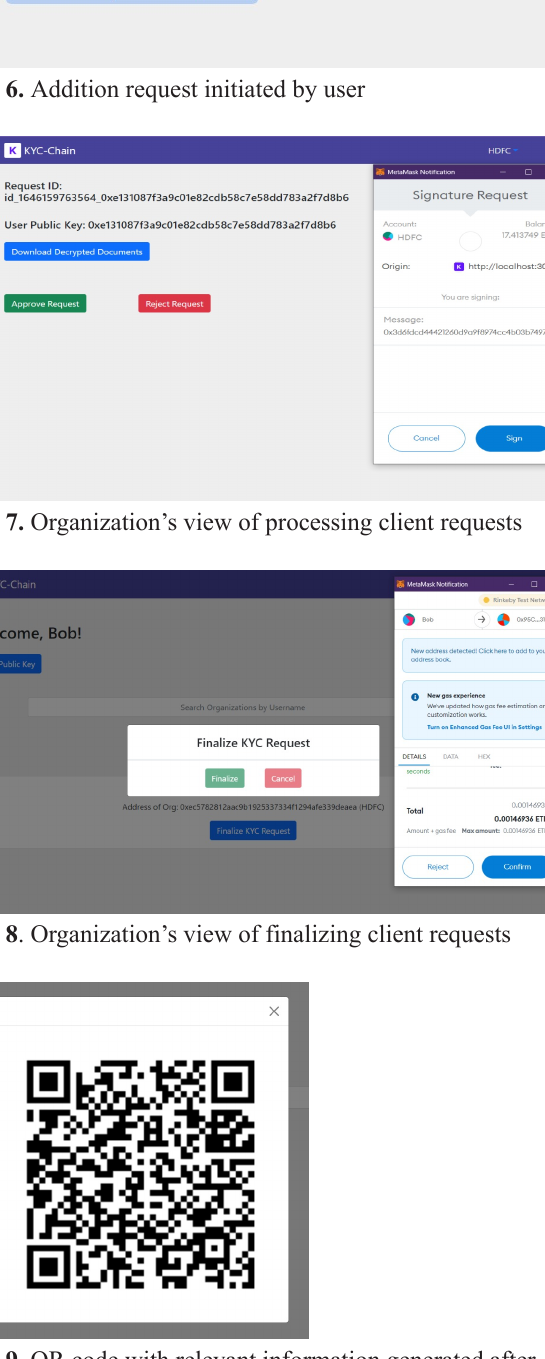
Fig. 10. User identification via OTP verification